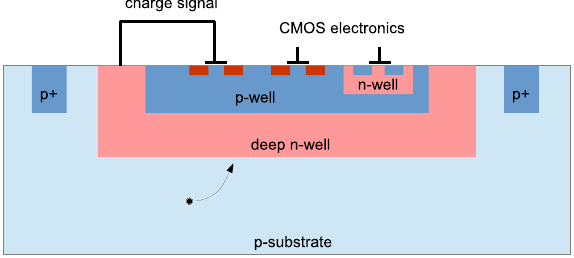
Figure 3. Diagram of a depleted CMOS DMAPS sensor with large fill-factor structure.